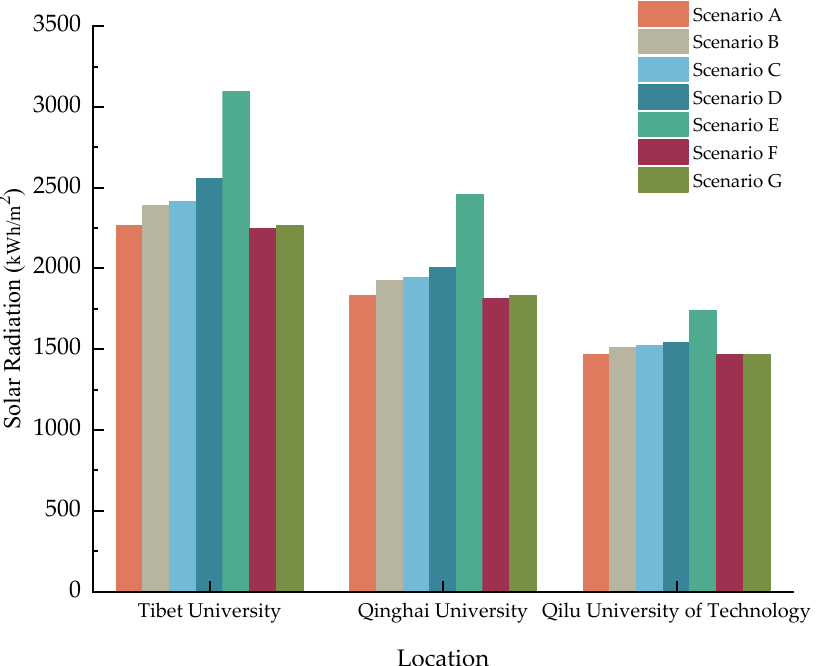
Figure 6. Annual solar irradiation obtained by PV systems under seven scenarios (data source from Reference [26]).